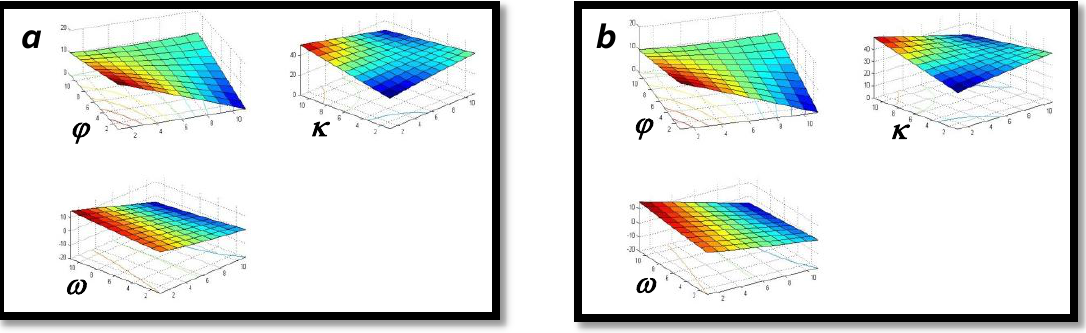
Figure 12. Three Euler angles values calculated via two different SQUAD sequences— a ( left ) and b ( right ) ( a and b are denoted as parabola motion in Figure 9)